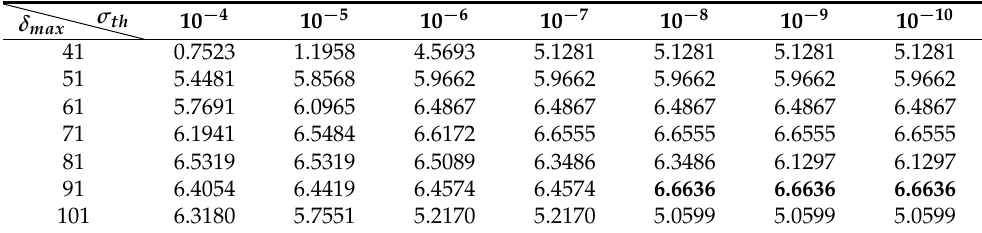
Table 4. The estimated multi-spectral fractal dimension (MFD) of multi-spectral fractal image with high generated complexity ( H =